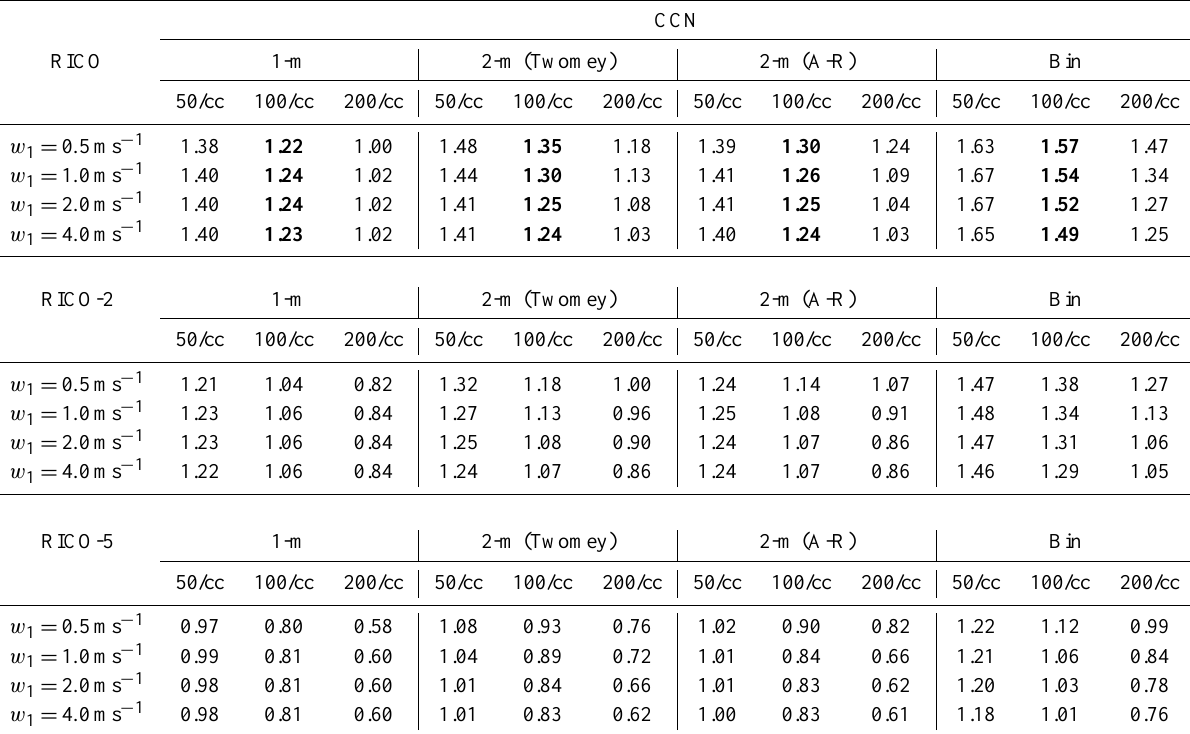
Table 4. Surface precipitation totals (mm) for each scheme as a function of CCN and w 1 for three different temperature profiles, namely RICO (top); RICO-2 (middle); and RICO-5 (bottom). Those results highlighted in bold type are plotted in Figs. 7 and 8 as timeseries of surface precipitation rate and accumulated surface precipitation